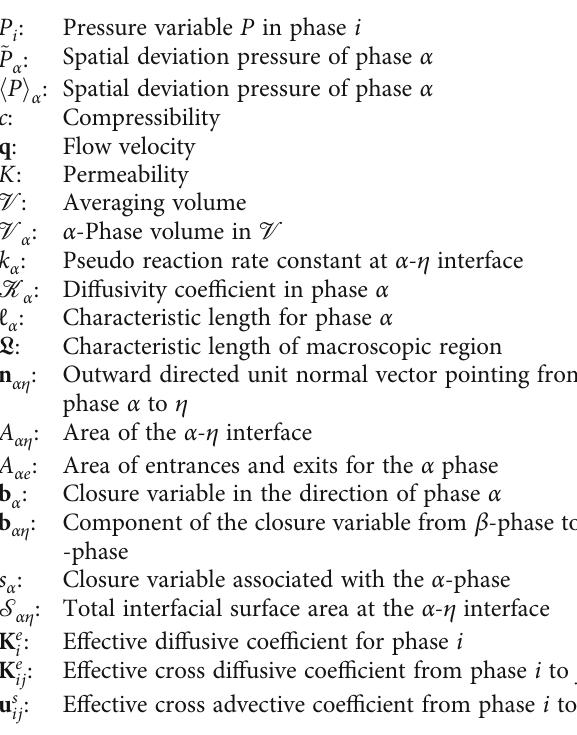
E ff ective di ff usive coe ffi cient for phase i K e : E ff ective cross di ff usive coe ffi cient from phase i to j ij u s : E ff ective cross advective coe ffi cient from phase i to ij